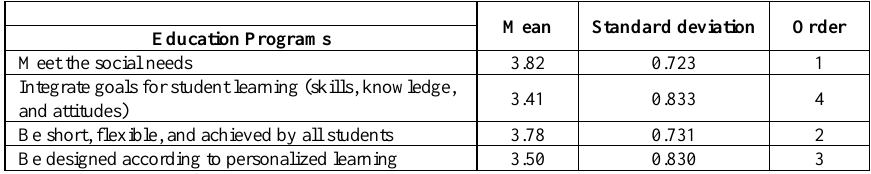
Table 2. Opinions about readiness in education programs for